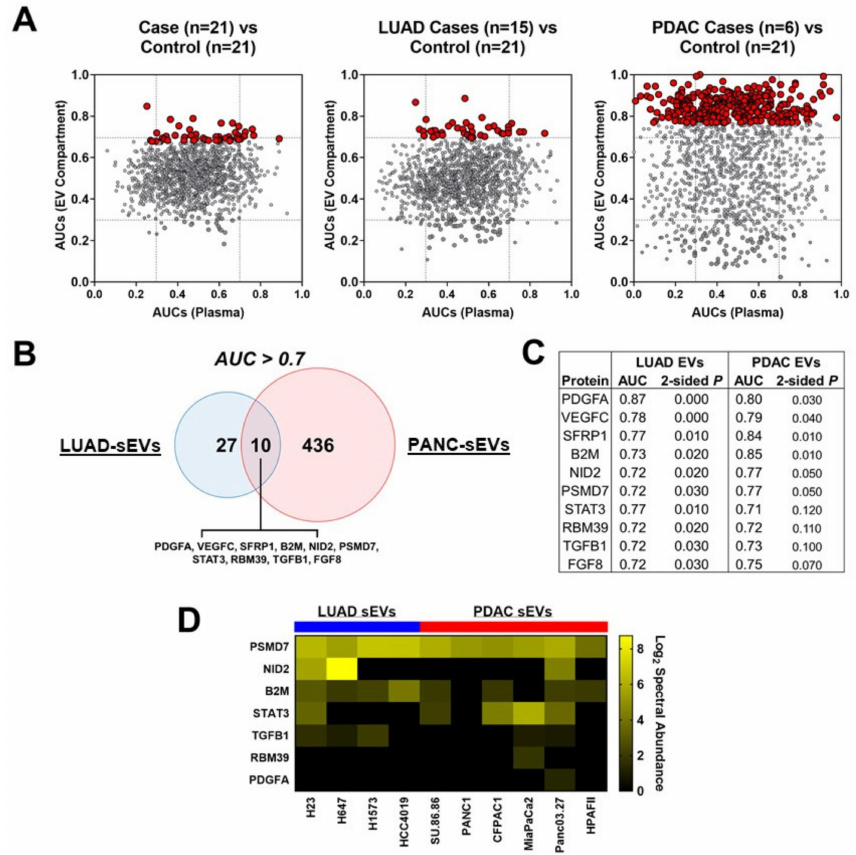
Figure 3. Profiling of adenocarcinoma patient plasma-derived sEVs. ( A ) Scatter plot illustrating Receiver Operating Characteristic (ROC) area under the curve (AUC) of aptamer array protein features identified in the sEV compartment (Y-axis) and matched unfractionated total plasma (X-axis) comparing all cases ( N = 21) versus controls ( N = 21), lung adenocarcinomas (LUAD) cases ( N = 15) versus controls ( N = 21) and pancreatic ductal (PDAC) adenocarcinoma cases ( N = 6) versus controls ( N = 21). Red nodes indicate protein features that were statistically significant (Wilcoxon rank sum test p < 0.05) in the sEV compartment. ( B ) Venn diagram for sEV-derived protein features with AUC point estimates > 0.7 in distinguishing LUAD and PDAC cases from cancer-free controls. ( C ) Table summarizing AUC and p -values for the 10 overlapping protein features that exhibited AUC point estimates > 0.7 for distinguishing both LUAD and PDAC cases from cancer-free controls. ( D ) Heatmap indicating cell line sEV protein log2 (Spectral Abundance) for overlapping features common between LUAD and PDAC cases ( C ) that were also identified (7 / 10) in the adenocarcinoma cell line-derived